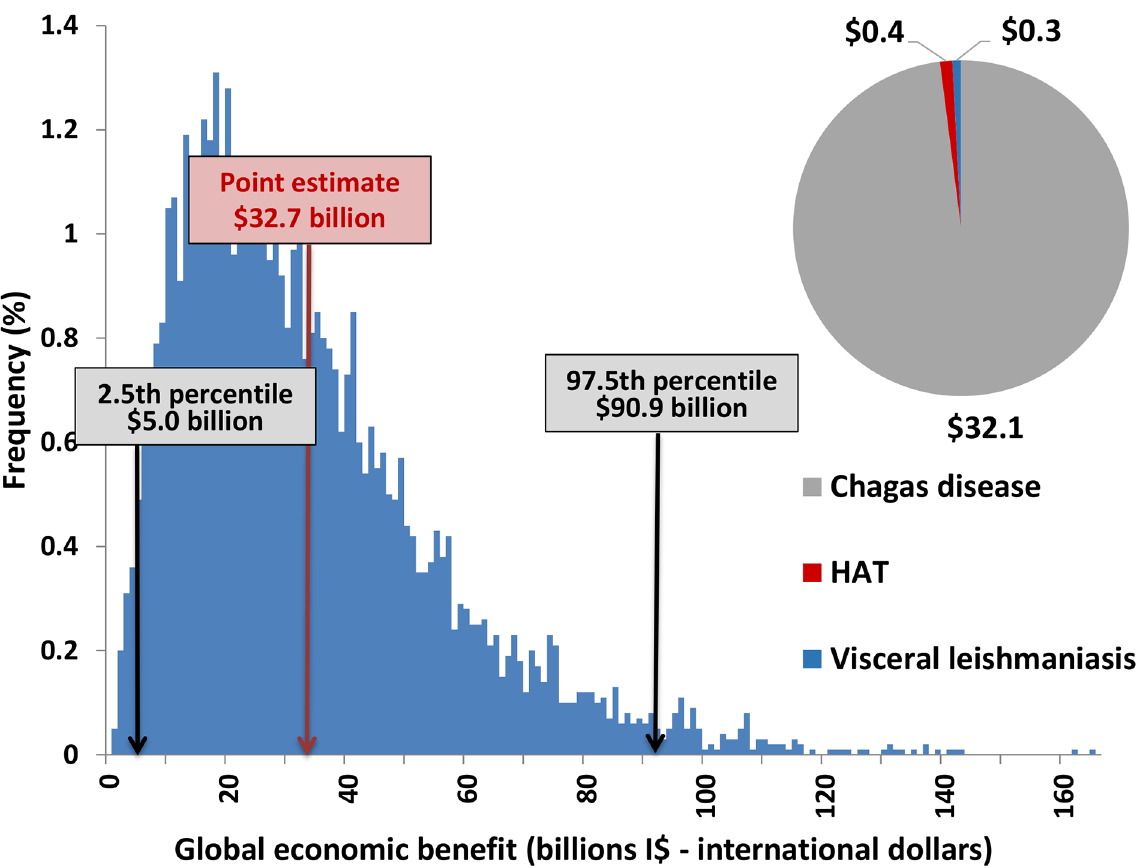
Fig 6. Global economic benefit (out-of-pocket payments averted) for IDM NTDs, for the period 2011–2030 (billions I$—International dollars). Total economic benefit from out-of-pocket payments averted, base case estimates and 2.5th and 97.5th percentiles (billions I$— international dollars), discounting 3% from